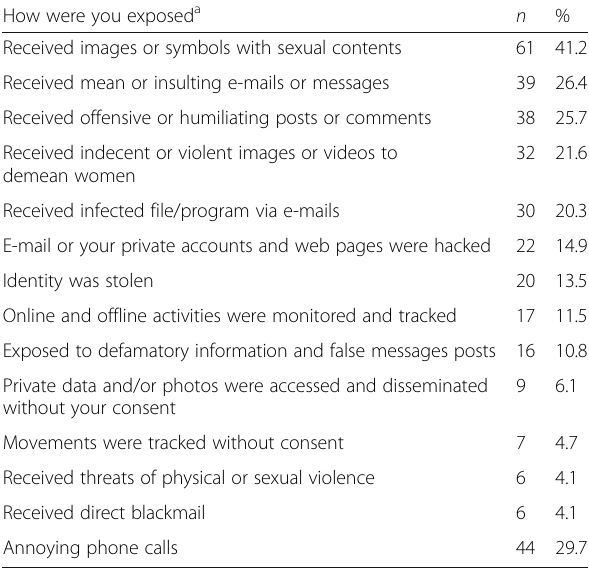
Table 2 Percent distribution of the exposed females by forms of cyber violence ( N = 148)